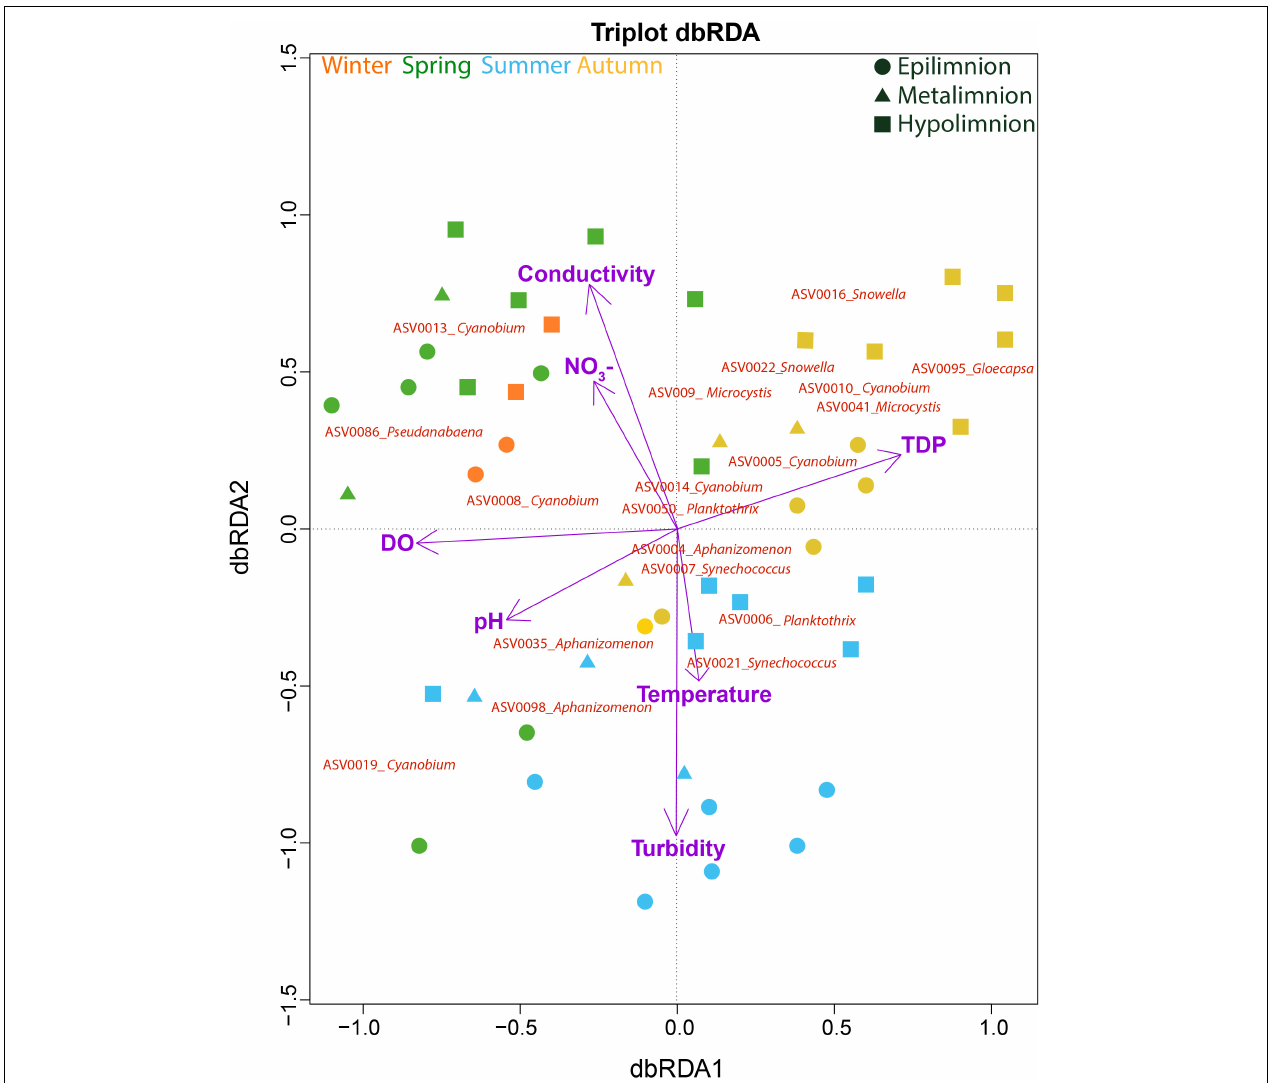
FIGURE 7 | Cyanobacterial composition in relation to environmental variables. Distance-based Redundancy Analysis (dbRDA) on the effect of environmental variables on cyanobacteria community composition. The total variation explained by the dbRDA model was 48%. The samples are color-coded according to seasons. The environmental variables explaining the variation in cyanobacteria community were all significant (adjusted R 2 = 0.34) and are projected as purple vectors. The response variables are shown at the ASV